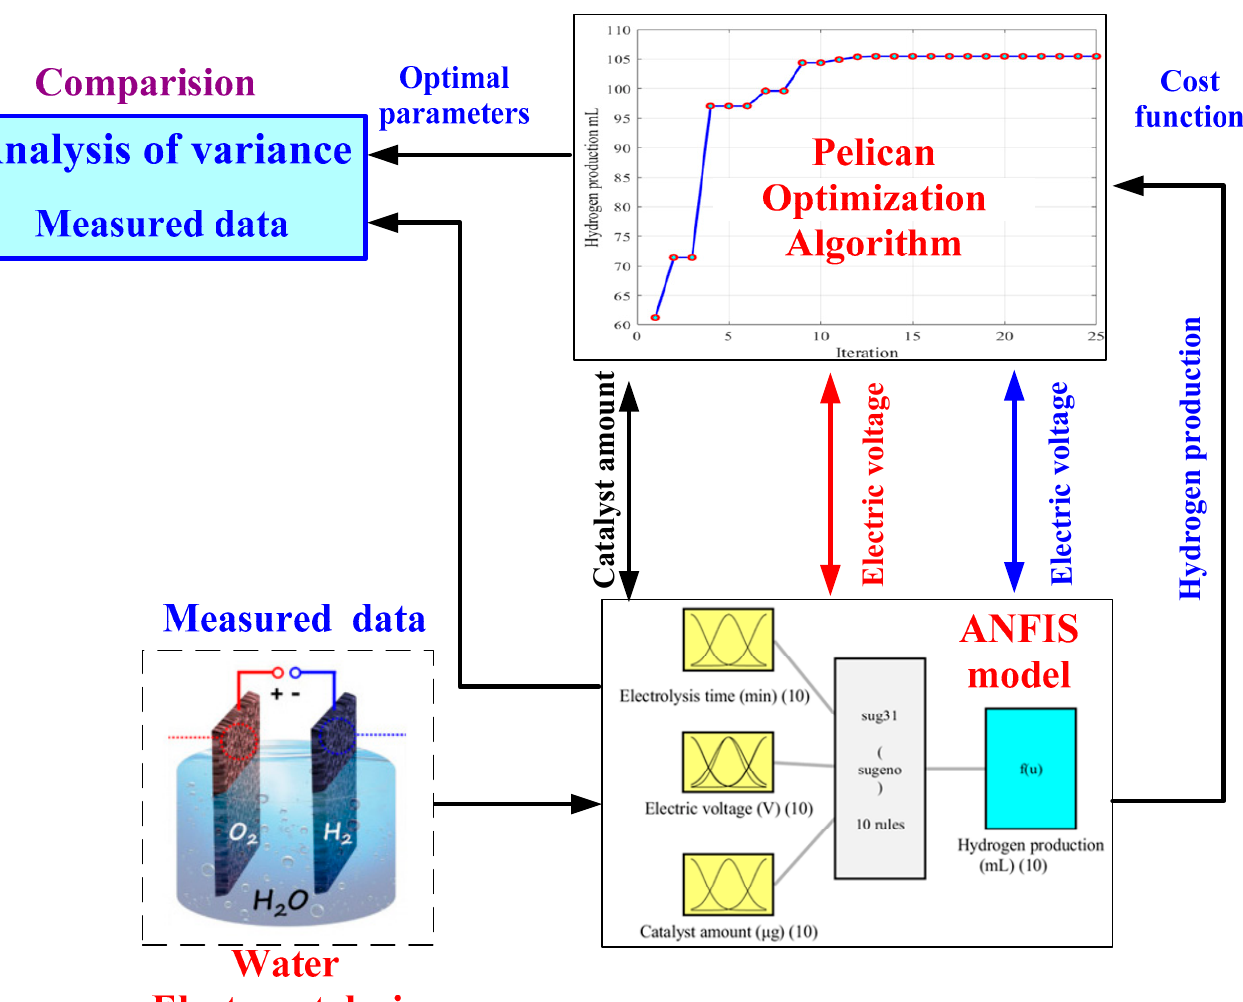
Figure 1. Layout of the methodology.